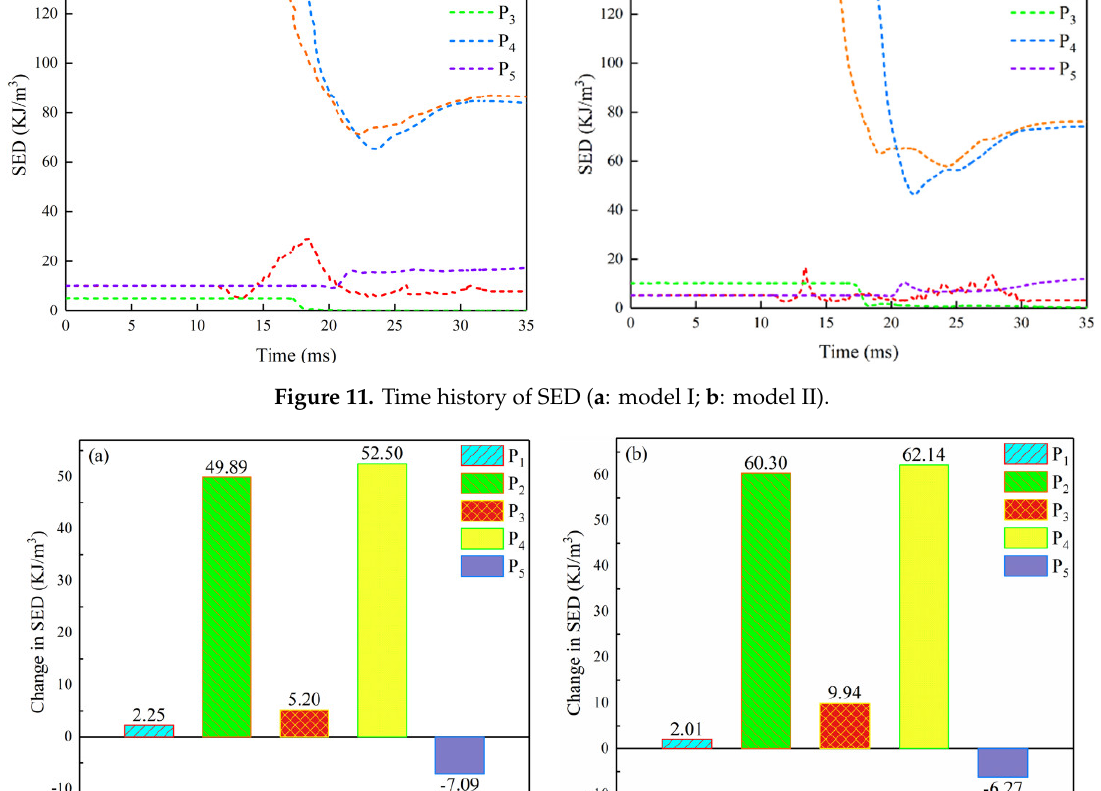
Figure 12. Changes in SED ( a : model I; b : model II).